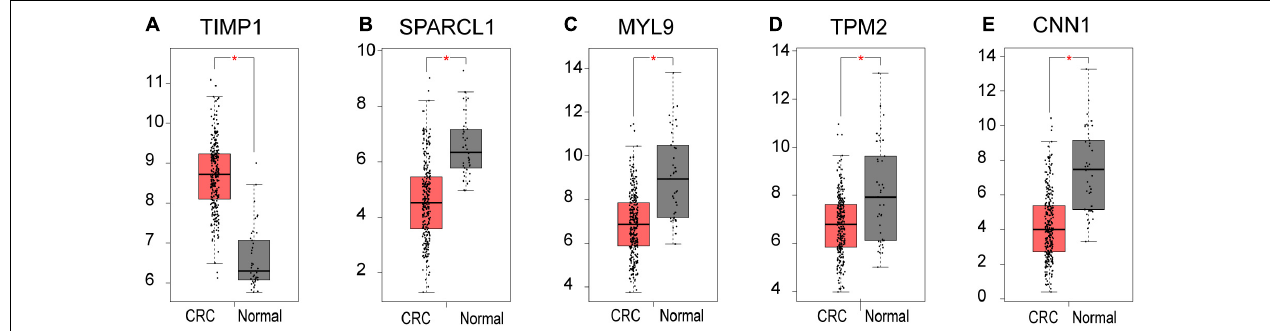
FIGURE 7 | The mRNA level of five hub genes in CRC. Validation of the mRNA expression levels of (A) TIMP1, (B) SPARCL1, (C) MYL9, (D) TPM2, and (E) CNN1 in CRC tissues compared with normal colon tissues from GEPIA database. These five box plots are based on 275 CRC samples (marked in red) and 41 normal samples (marked in gray). * P < 0.01 was considered statistically significant. CRC, colorectal cancer. VEGFC and F8 were filtered out according to the P -value of the mRNA expression levels.